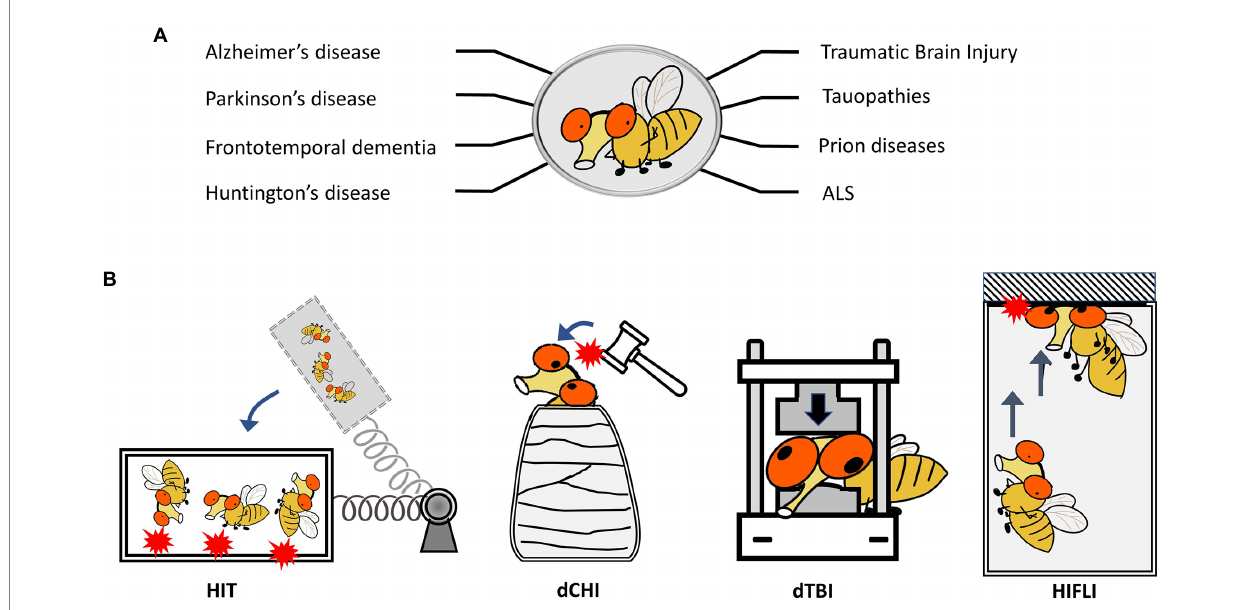
FIGURE 1 Drosophila melanogaster as a model to study neurodegenerative diseases and TBI. (A) Representative neurodegenerative diseases modeled in Drosophila . (B) Schematics showing four Drosophila models for TBI-related research. HIT: high impact trauma model by Katzenberger et al. (2013). dCHI: Drosophila controlled head-impact model by van Alphen et al. (2022). dTBI: Drosophila TBI model using a Piezoelectric actuator by Saikumar et al. (2020). HIFLI: Headfirst Impact FLy Injury model by Behnke et al.